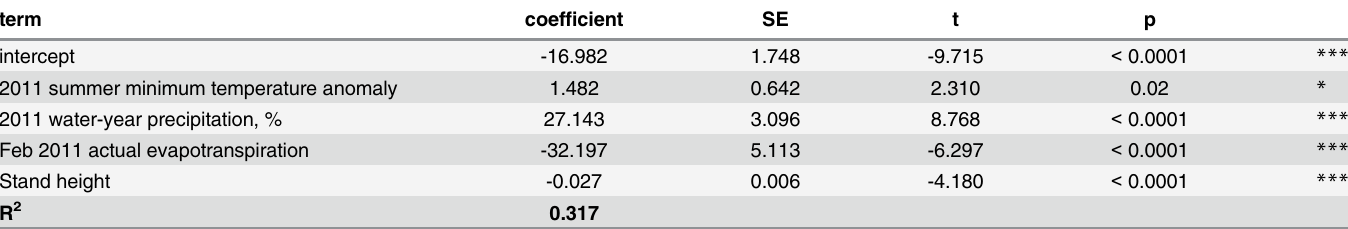
Table 5. Final regression model of drought impact patch hotspots (2-km kernel density) as a function of environmental variables related to water availability and forest height.